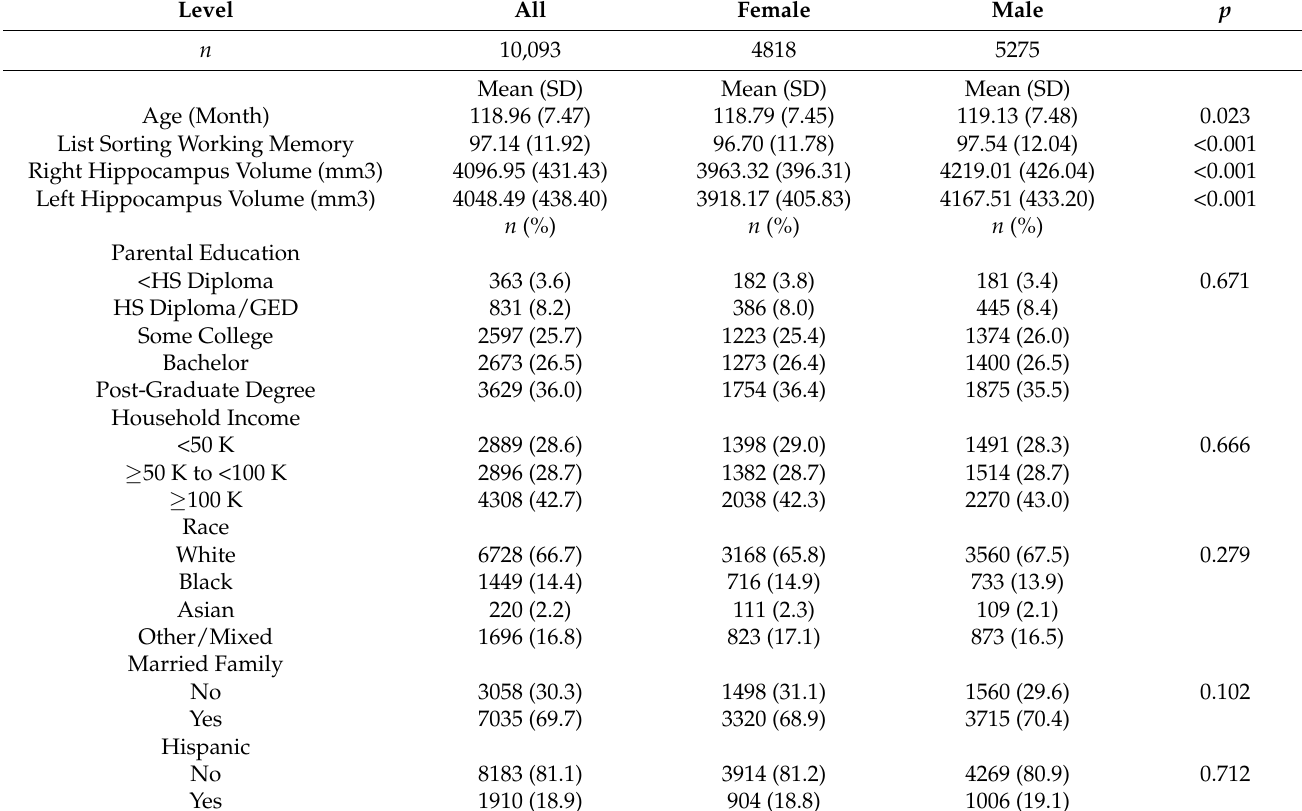
Table 1. Descriptive statistics overall and by